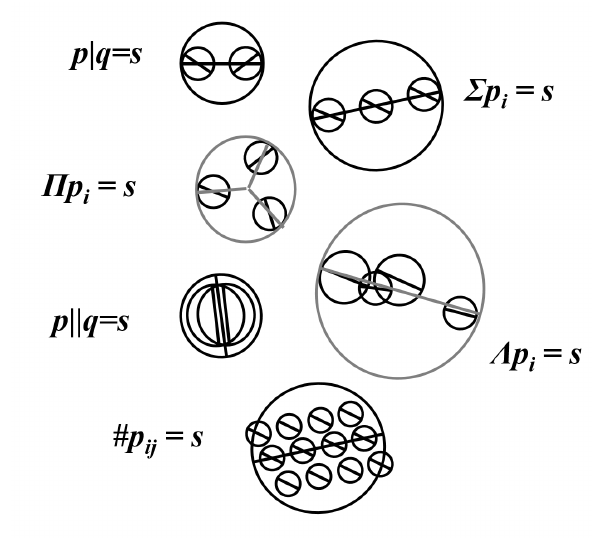
Figure 1. Operations on the Gestalt domain as given in (Micha- elsen and Meidow, 2019), gestalts are displayed as circles with location at the center, scale as diameter, orientation as radius line, frequency as number of spokes, and assessment as gray tone Proximity is combined with other laws, an important one being similarity in orientation . Recall orientations are given in a conti- nuous additive group which is not a metric space. In (Michaelsen and Meidow, 2019) we proposed the use of functions that give 1 for no orientation difference, and 0 for maximal difference in orientation such